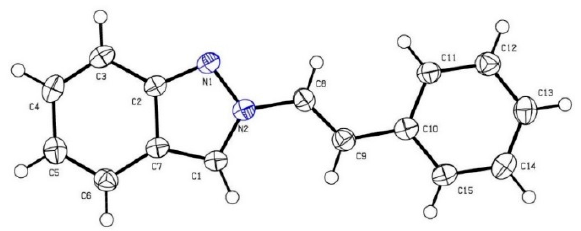
Figure 1. ORTEP plot of X-ray crystallographic data for 2a .